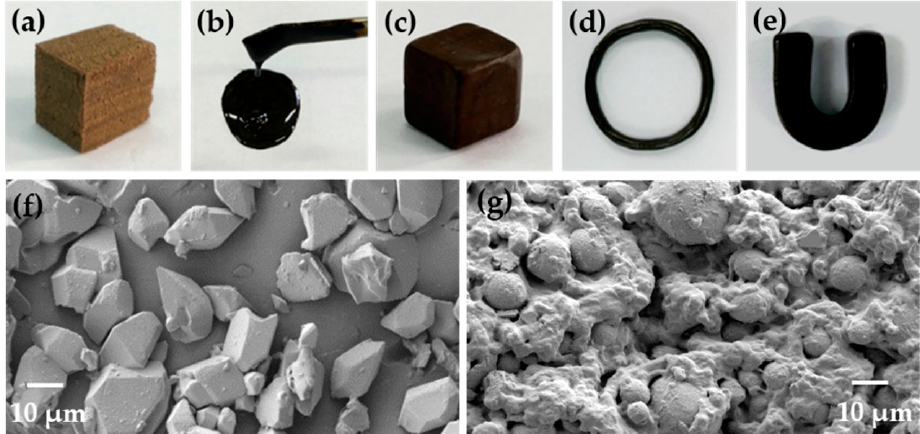
Figure 1. The surface morphology and plasticity of real samples. ( a – b ) Digital photos of sulfur cottonseed oil (SCO) and sulfur fatty acid of cottonseed oil (SCOF), respectively; ( c – e ) digital images of sulfur–sodium soap of cottonseed oil (SCOS): ( c ) cubic SCOS, ( d ) ring-shaped SCOS and ( e ) U-shaped SCOS; ( f – g ) SEM images of SCO and SCOS, respectively (m S : m COX = 1:1).